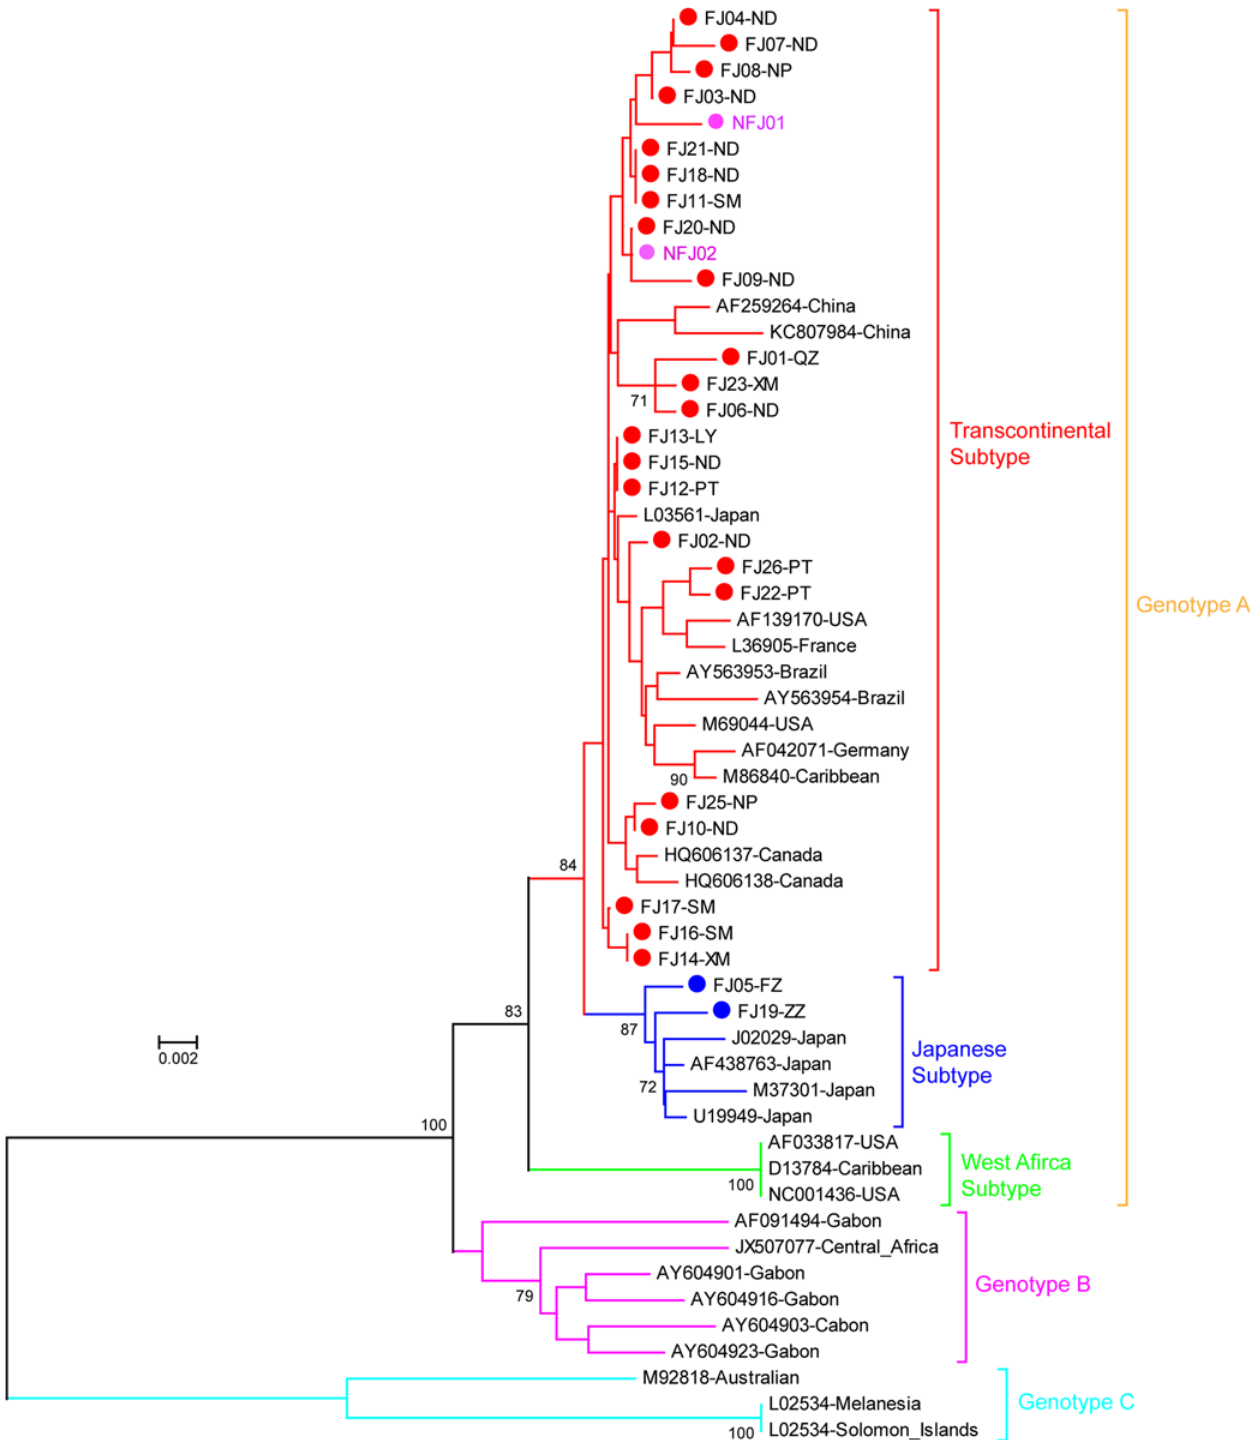
Fig 3. Phylogenetic tree constructed using HTLV-I gp46 sequences by neighbor-joining with Maximum Composite Likelihood corrected distances. Support for the branching order was determined by 1000 bootstrap replicates; only values of 70% or more are shown. For 27 new sequences of this study, 25 sequences of transcontinental subtype were indicated by red (sequences from donors born in Fujian) or purple (sequences from donors born in Non-Fujian province) dots, and 2 sequences of Japanese subtype were indicated by blue dots. FJ, Fujian province; NFJ, Non-Fujian province; FZ, Fuzhou city; XM, Xiamen city; PT, Putian city; QZ, Quanzhou city; ZZ, Zhangzhou city; LY, Longyan; NP, Nanping city; SM, Sanming city; ND, Ningde city.